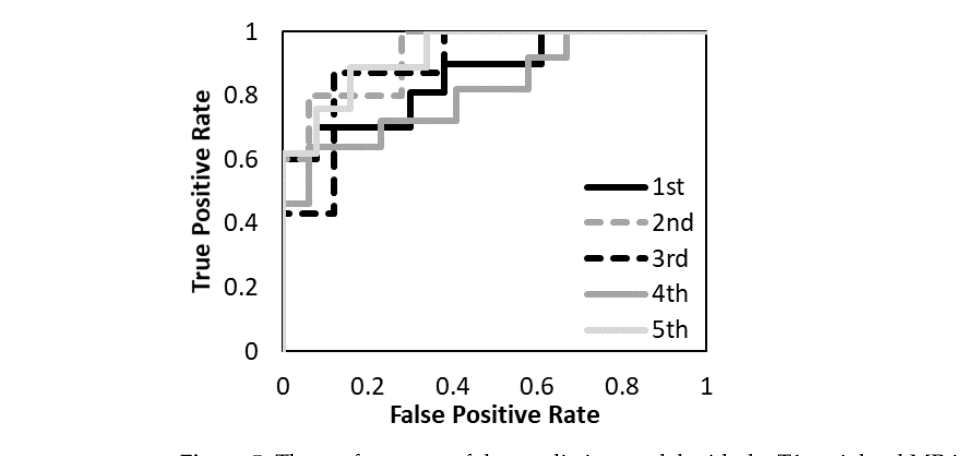
Figure 5. The performance of the predictive model with the T1-weighted MR image was evaluated according to the ROC metrics.